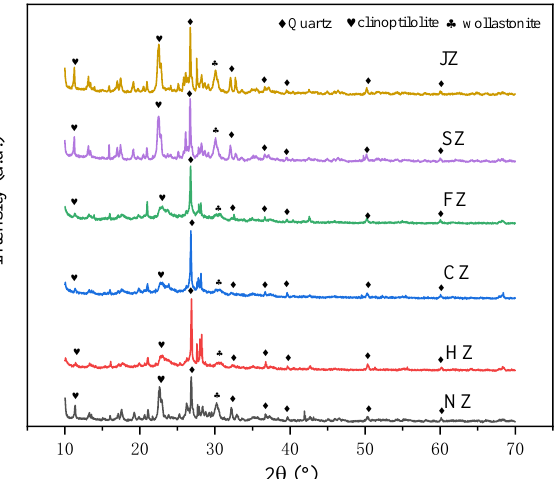
Figure 1. XRD patterns of zeolite. SZ: Na 2 S modification; JZ: NaOH modification; CZ: ultrasonic modification; FZ: humic acid modification; HZ: high-temperature modification; NZ: natural zeolite.